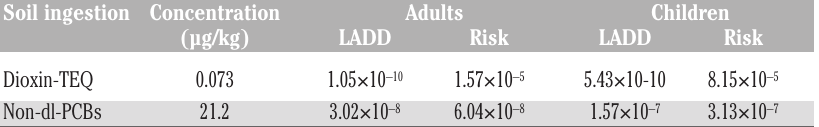
Table 5. Calculated polychlorinated biphenyl exposure from urban soil and risk for adults and children. Soil ingestion Concentration